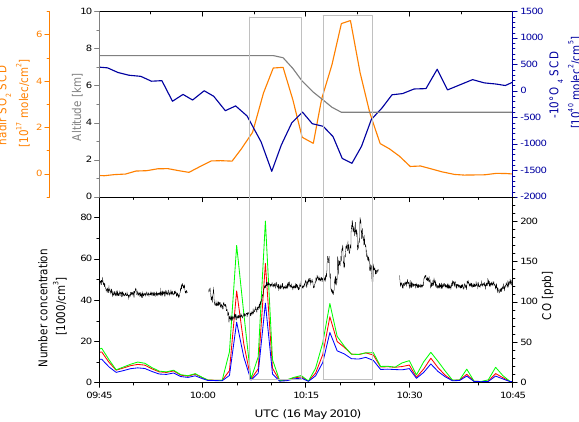
Fig. 8. Overview of some additional CARIBIC observations and the DOAS SO 2 and O 4 data (Fig. 6). Three increases in the aerosol number concentrations occurred. The green, red and blue line cor- responds to the size bin above 4 nm, above 12 nm and above 18 nm respectively. The first two peaks are observed at 7600 m, the third one is at a lower flight level (4600 m). The gaps in the CO data are caused by regular automated in-flight-calibration; fortunately the calibrations were performed just before and after crossing the plume.